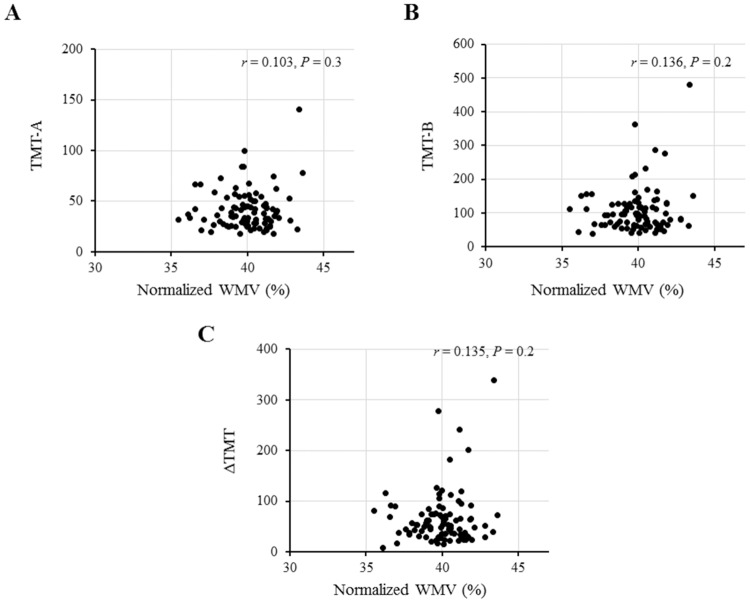
Correlations between normalized white matter volume (WMV) and the scores (times in seconds) of Trail Making Test (TMT).No correlations are found between normalized WMV and each score of TMT-A (A), TMT-B (B), and ΔTMT (C).